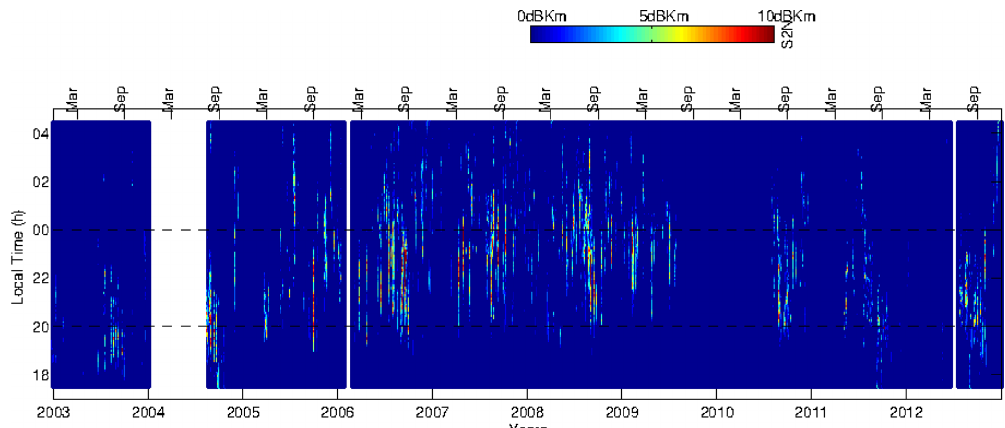
Figure 2. VHF radar data are presented as altitude integration from 200 to 1000km height as a function of the signal-to-noise ratio (dBKm). The horizontal lines represent local sunset and local midnight to help observations of echo distribution.